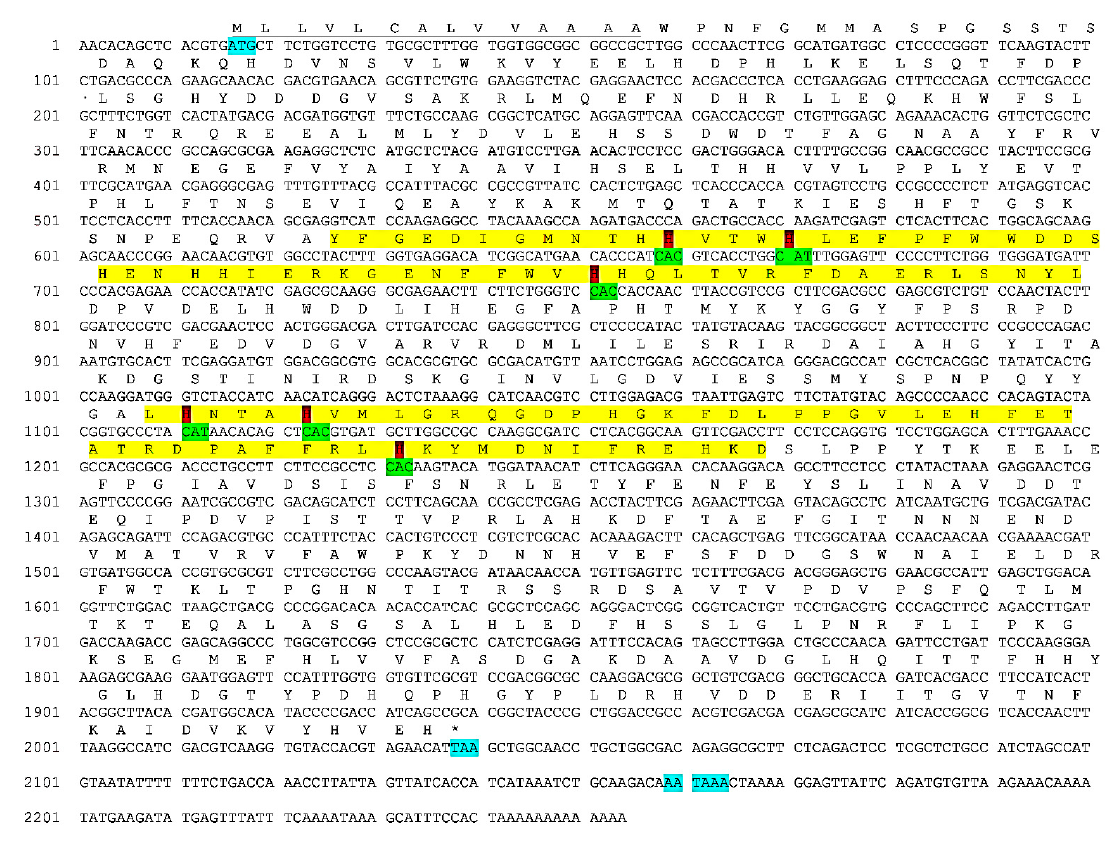
Figure 1. Complete nucleotide sequence, open reading frame (ORF) and the amino acid sequence of Eriphia verrucosa Hc. The main elements are highlighted as follows: ATG–start codon, TAA-stop codon and AATAAA–polyadenylation signal with turquoise color, the oxygene–binding regions CuA and CuB–with yellow color. The 6 Cu-binding histidines, among which 3 in CuA and 3 in CuB, respectively are given in red color. The N-terminal signal peptide is underlined.